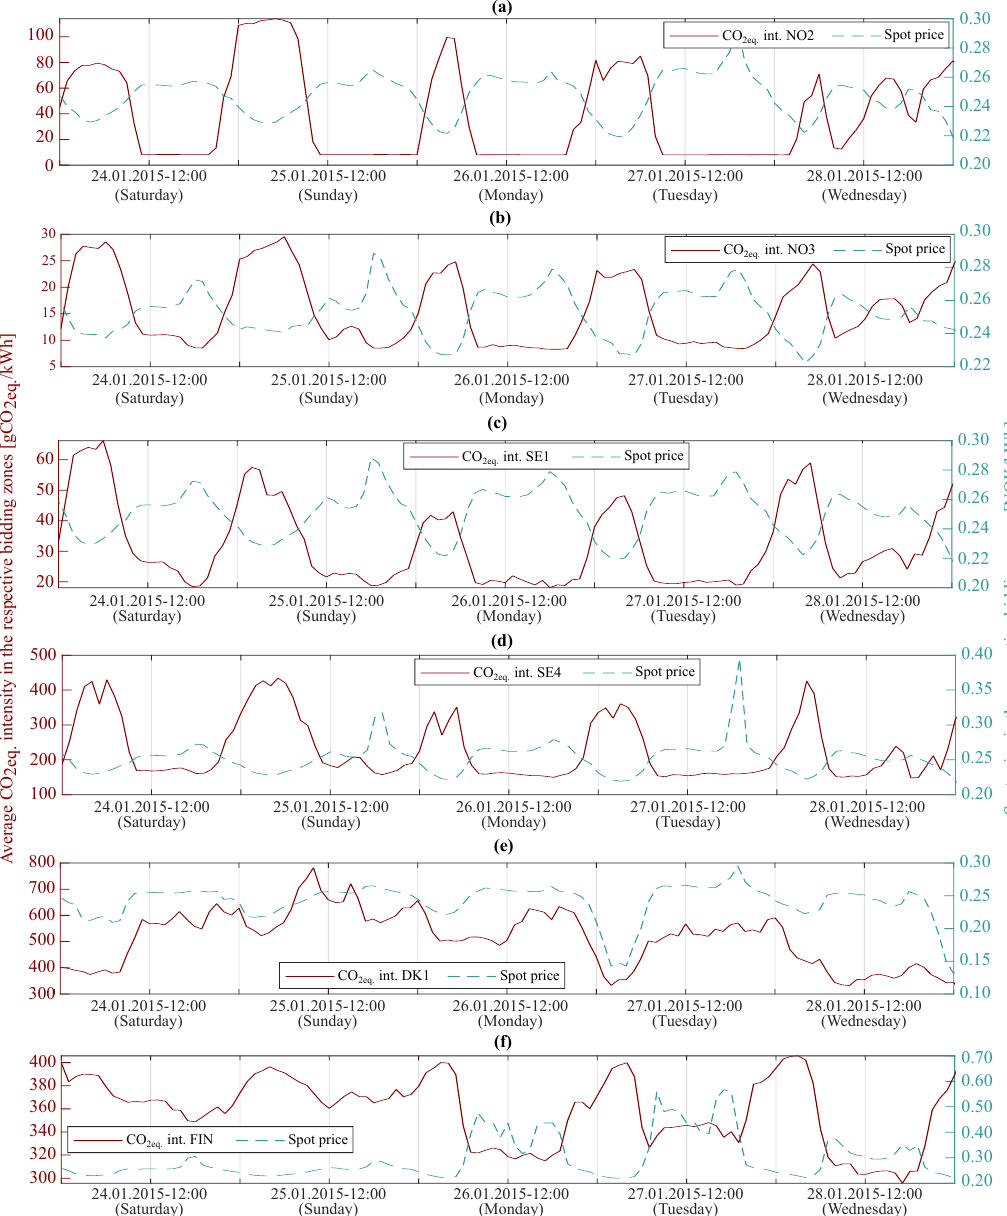
Figure 3. Average CO 2eq. intensity and spot prices for five exemplary days in 2015 for six Scandinavian BZs: ( a ) NO2, ( b ) NO3, ( c ) SE1, ( d ) SE4, ( e ) DK1, and ( f )